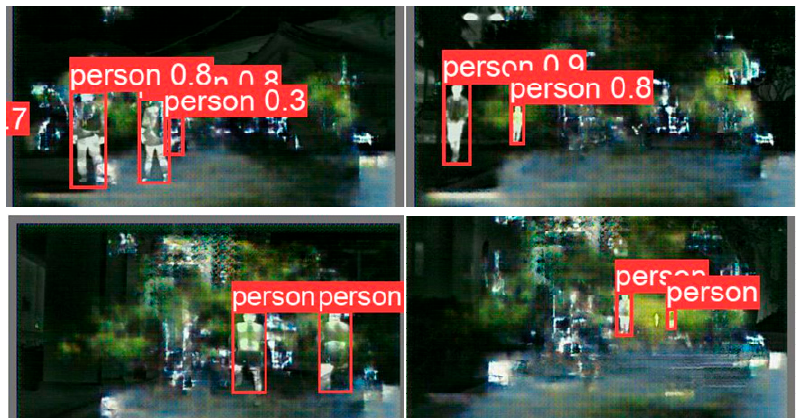
Figure 10. New generated images by RCGAN network.